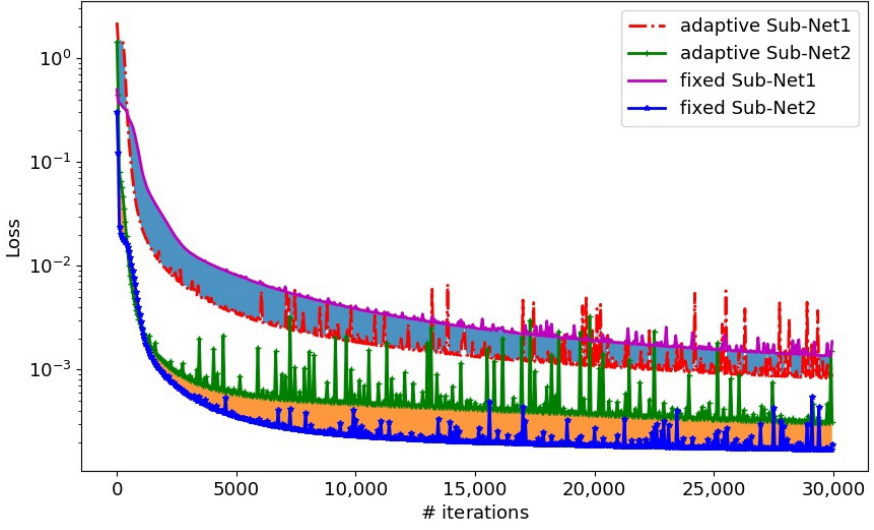
Figure 22. ( a ) The PINN solution and ( b ) the error between PINN and the exact solution on internal domain.